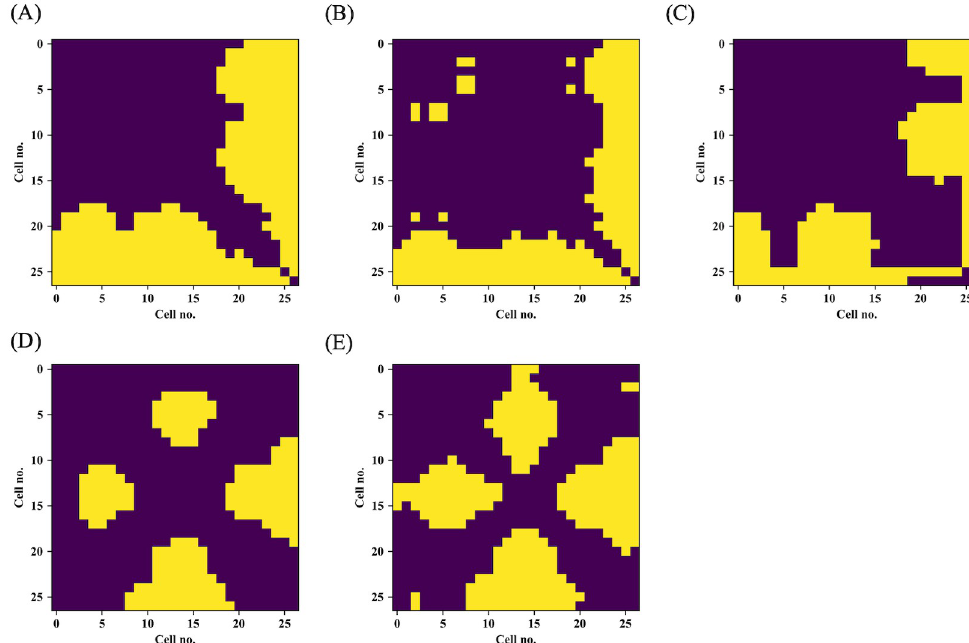
Fig 8. Results of Steel-Dwass test applied to anatomical parameters and S 2 microfibril angle (MFA). (A) Cell wall occupancy, (B) lumen radial diameter, (C) tangential wall thickness, (D) S 2 MFA on radial walls, and (E) S 2 MFA on tangential walls. In these matrices, yellow color cells indicate the statistically significant pairs ( P < 0.05). Observation cell number is 432.